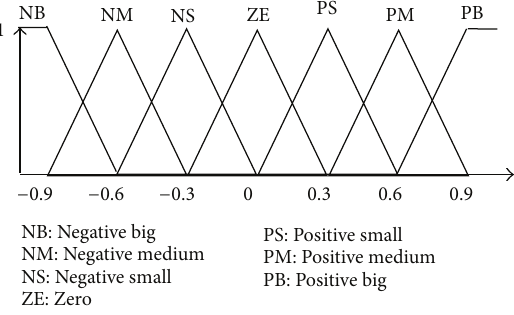
Figure 3: Membership functions of 𝑒 , Δ𝑒 , and 𝑈